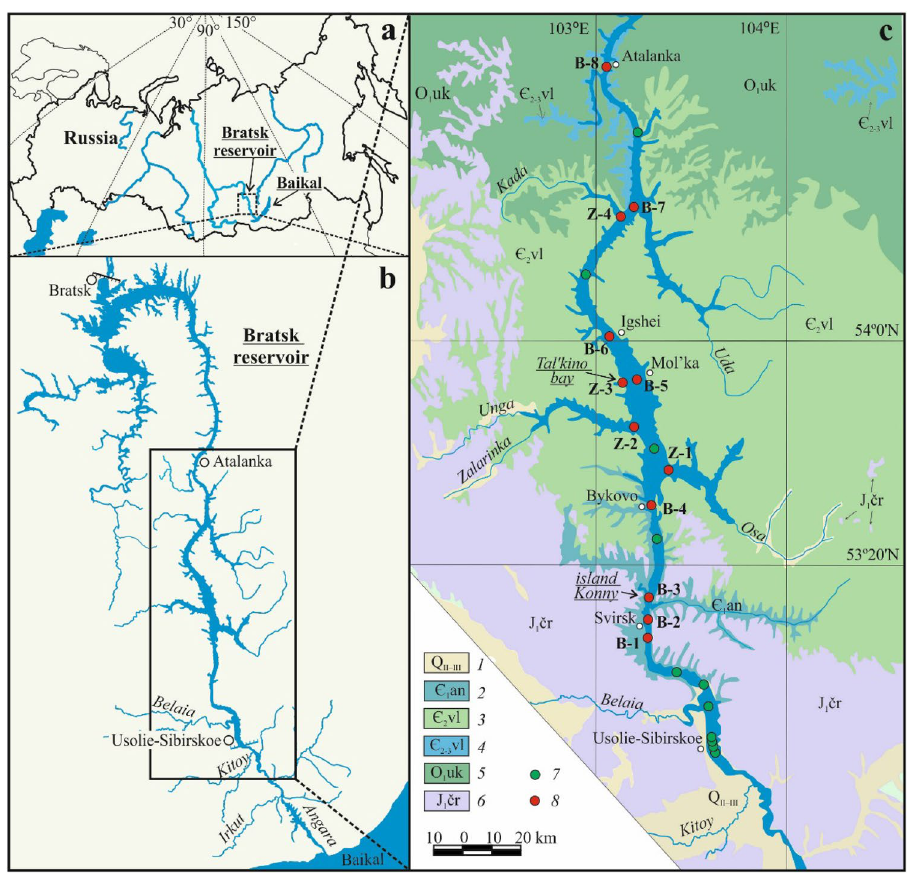
Figure 1. ( a ) Location of the Bratsk reservoir. ( b ) View of the wider study area. ( c ) Schematic geologic map with indicated sampling locations. Schematic maps, showing the locations within the studied area and geology structure of the area under study are taken from a digital catalog and are freely accessible (http:// geo. mfvse gei. ru). Figure was created using CorelDRAW (21.3.0.755, www. corel. com). ( c ) 1—alluvial deposits (sand, pebbles, sandy loam); 2—lower Cambrian Angara formation (dolomites, anhydrite-dolomites, gypsum, rock salt); 3— Middle Cambrian Upper Lena formation (sandstones, siltstones, marls, mudstones, gypsum); 4—Middle-Upper Cambrian Vilyu formation (sandstones, siltstones, marls); 5—Lower Ordovician Ust-Kut formation (siltstones, mudstones, sandstones); 6—Jurassic sediments, Cheremkhovo formation (conglomerates, sandstones, siltstones); 7—sampling locations of overlying water; 8—sampling locations of overlying and pore